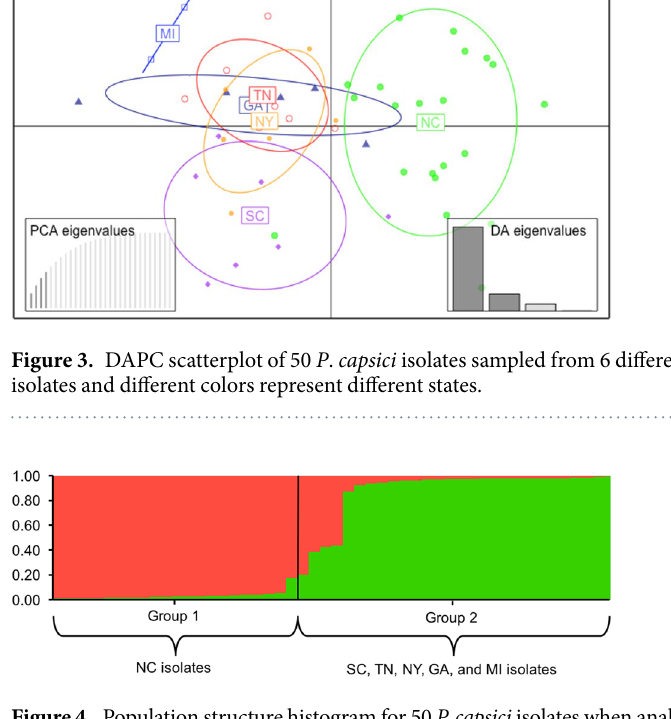
Figure 4. Population structure histogram for 50 P. capsici isolates when analyzed with 12 microsatellite markers using STRUCTURE. Color on each bar indicates membership probability of belonging to a corresponding